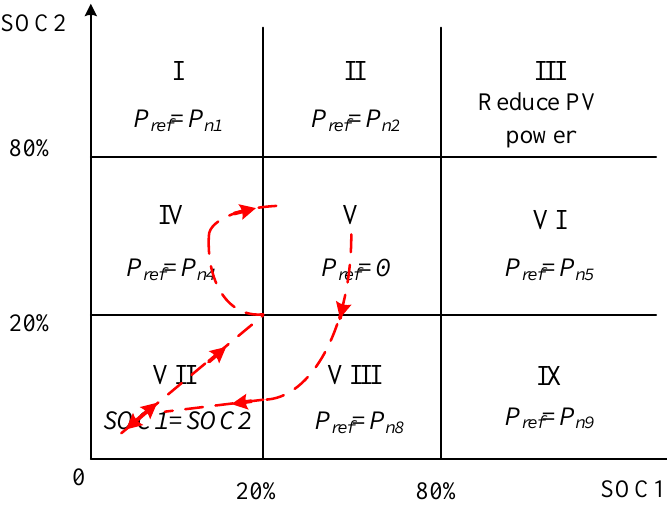
Figure 14. Quadrant switching path of case 3.